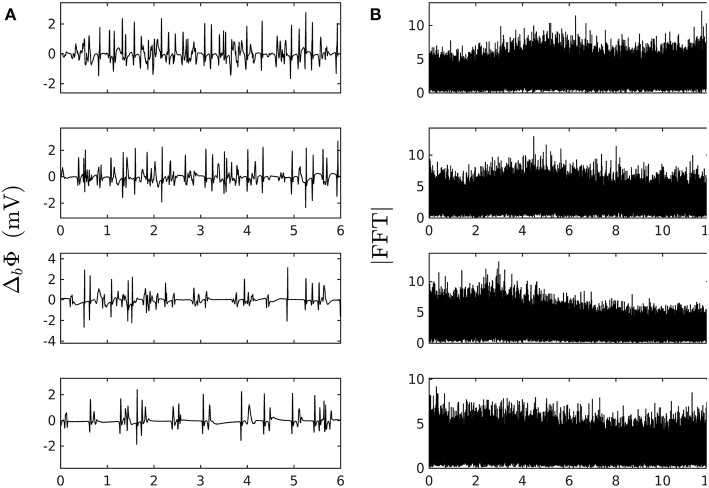
Numerically simulated pseudo bipolar potential. (A) 6 s time-series Δb Φ (Equation 12) are generated at positions x (in δx = 0.3 mm units) = 8, 18, 75 and 134 (from top to bottom) with our model defined in Equations (6)–(8) with parameter values defined in Simul #2 (Table 1), L = 150 (in δx = 0.3 mm units). (B) Corresponding Fourier transform power spectra. No attempt was made to reproduce the high and low pass filtering used in real bipolar catheter acquisitions. The natural point source frequency at the boundary is ∽ α γ ≈ 5 Hz. Rarefaction of pulses occurs as one moves away from the source which is a hint at some randomly back-scattered pulses that collide and annihilate up-following pulses without reexciting new pulses.